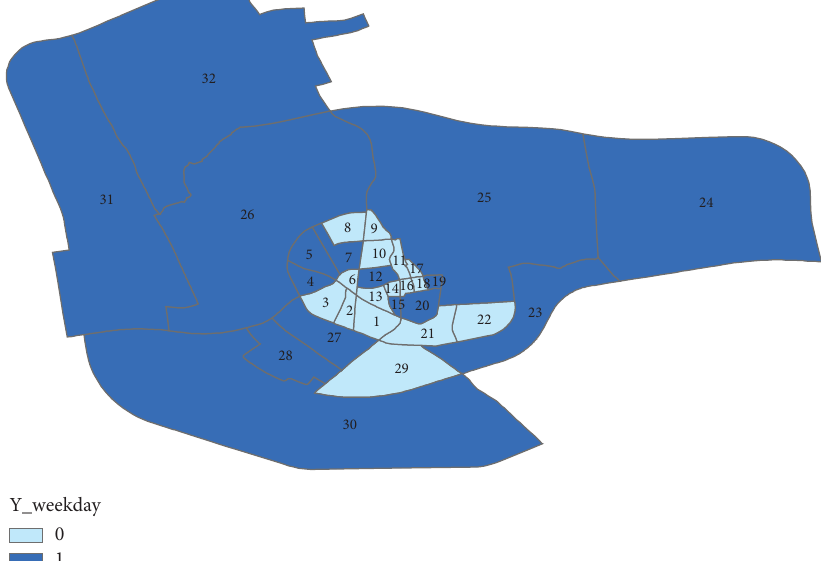
Figure 4: Spatial distribution of average weekday travel fow